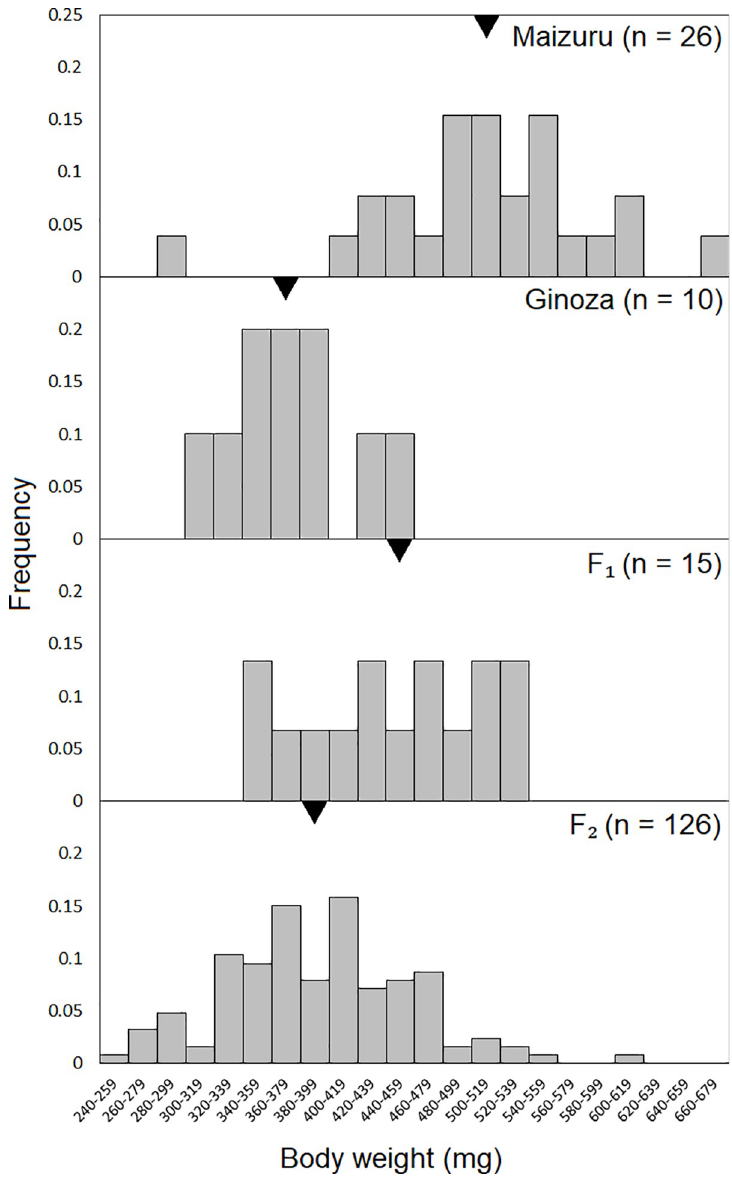
Fig 2. Distribution of body weight of the Ginoza, Maizuru, F 1 , and F 2 fish. The Y axis indicates the frequency; the X axis indicates the body weight categories at 20-mg intervals. Black triangles indicate the means.